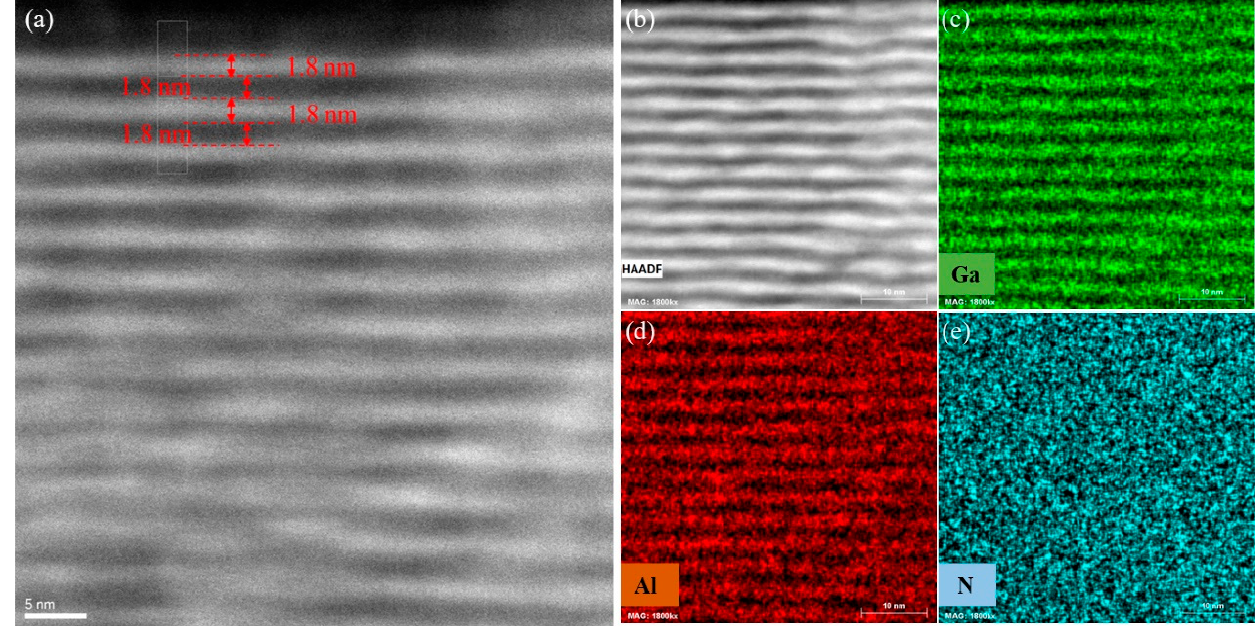
Figure 3. ( a ) GaN/AlN quantum wells scanning transmission electron microscope high-angle annular dark-field image (STEM HAADF). Due to higher Z contrast, the brightness of GaN layer is higher than that of AlN. It is marked in the figure that the thickness of GaN and AlN are 1.8 nm. ( b ) Scanning transmission electron microscope high-angle annular dark field image(STEM HAADF) of GaN/AlN quantum well with 10 nm scale. Used to measure the distribution of elements in the quantum well layers. ( c – e ) are, respectively, the distribution mappings of Ga, Al, and N elements in the corresponding quantum well layers of ( b ).